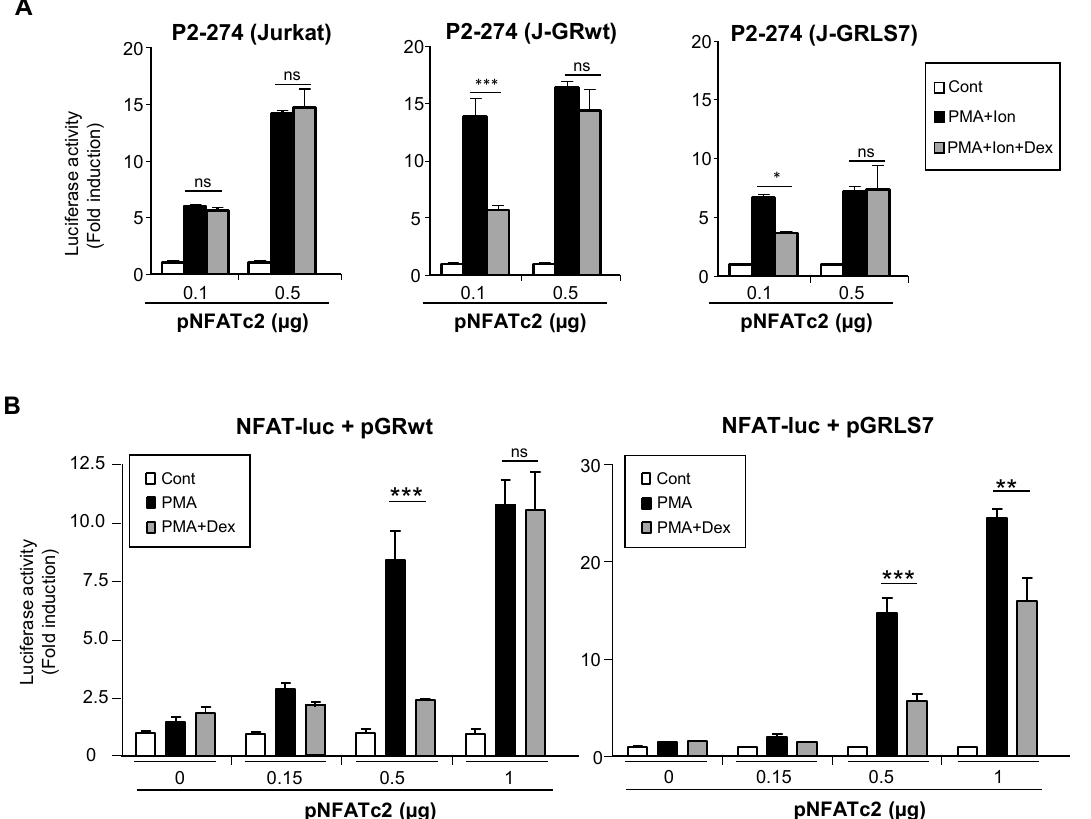
Figure 6. Negative cross-talk between GR- and NFAT-mediated transcription. ( A ) Parental, J-GRwt, and J-GRLS7 Jurkat cells were transiently transfected with the COX-2 promoter construct P2-274-Luc together with increasing quantities of NFATc2 expression plasmid as indicated. Cells were treated for 1 h with Dex (1 μ M) before O/N PMA + Ion (15 ng/mL + 1 μ M) stimulation. ( B ) Jurkat cells were transiently transfected with the NFAT reporter construct pNFAT − Luc together with pGRwt or pGRLS7 expression plasmids along with increasing quantities of an NFATc2 expression plasmid ( μ g). Cells were treated for 1 h with Dex (1 μ M) before O/N PMA (15 ng/mL) treatment. After transfection, cells were lysed, and luciferase activity was determined. Results shown are from a representative of two independent experiments performed in triplicate, and are expressed as fold induction mean of PMA + Ion or PMA samples over unstimulated control ones (mean ± SEM). ns: non-significant; * p < 0.05; ** p < 0.01; *** p < 0.001; vs. PMA + Ion or PMA treatment.